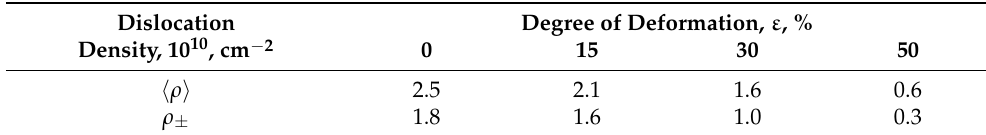
Table 2. A dependence of the scalar (cid:104) ρ (cid:105) and excess ρ ± dislocation density in fragments on the degree of deformation.